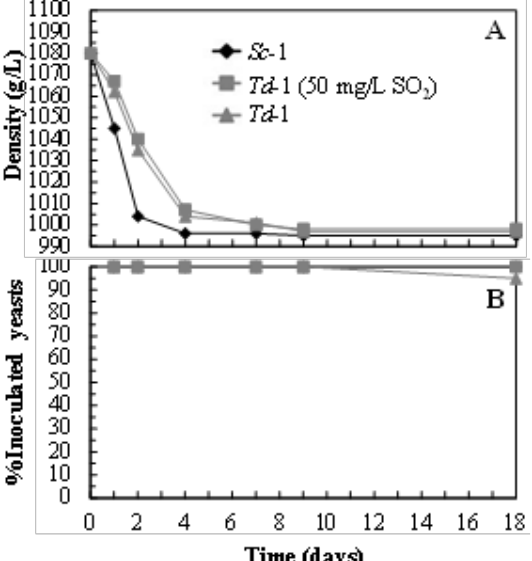
Figure 5. Must fermentation kinetics ( A ) and yeast population dynamics ( B ) of Pinot Noir grape fermentation inoculated with S. cerevisiae ( Sc ) and T. delbrueckii ( Td ) in the absence and presence of 50 mg/L SO 2 .